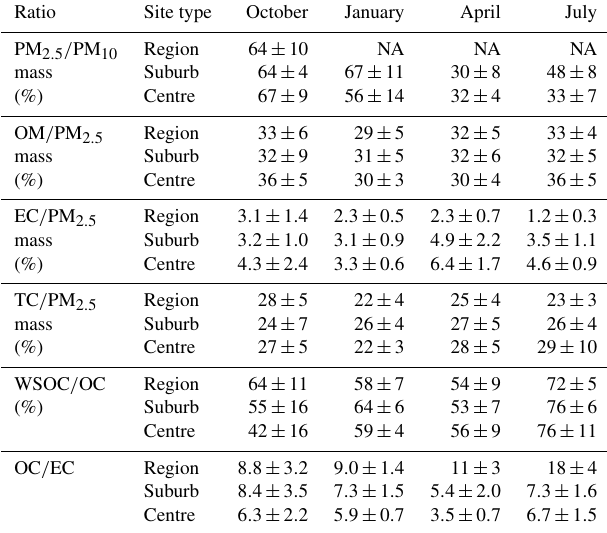
Table 3. Mean values and SDs for the PM 2 . 5 / PM 10